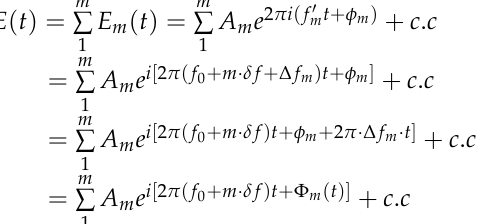
Figure 3. Schematic diagram of mode-locking in time or space domain in a Fabry-Pérot cavity. If we suppose that the electric field of one longitudinal mode, for example the m th one, is E m ( t ) = A m e 2 π i ( f m t + φ m ) + c . c . Adding the electric fields of all these resonant modes together will give us the laser emission in the time domain: